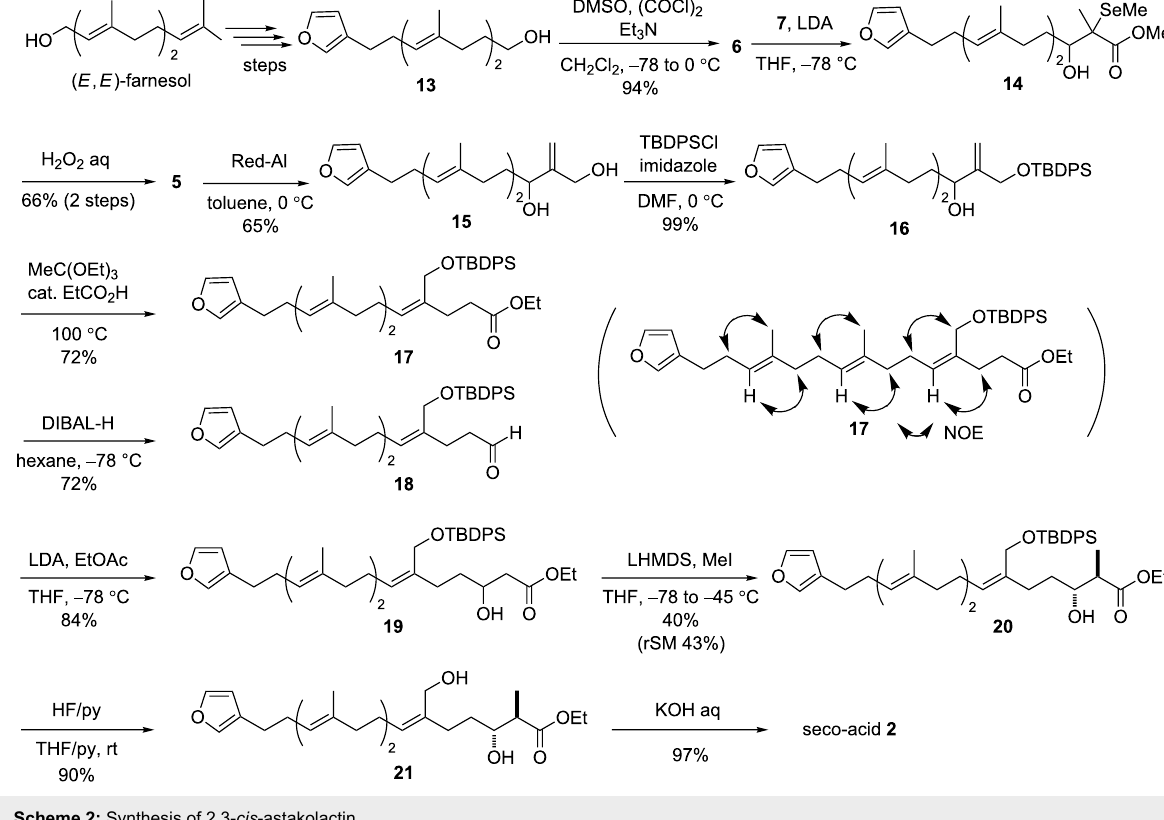
Scheme 2: Synthesis of 2,3- cis -astakolactin.